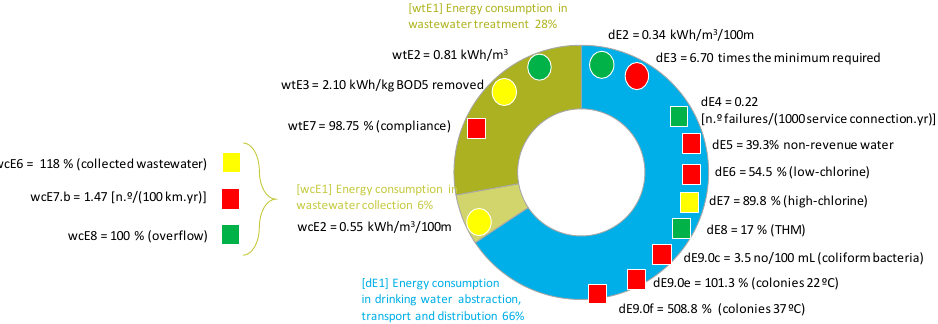
Figure 4. Energy consumption, energy efficiency and effectiveness in water Utility K, for the three UWS stages (level 2 of analysis) (the pie charts represent the energy consumption in each stage–drinking water in blue, wastewater collection in light brownish-green, wastewater treatment in dark brownish-green; the circles represent the energy efficiency PIs and the squares the effectiveness PIs).